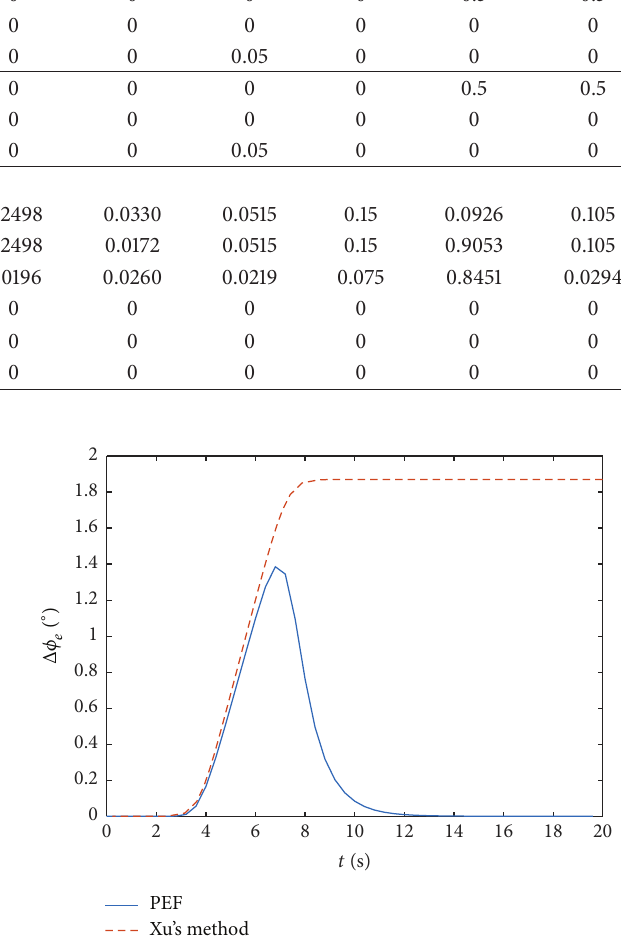
Figure 4: The variation of the end-effector’s attitude